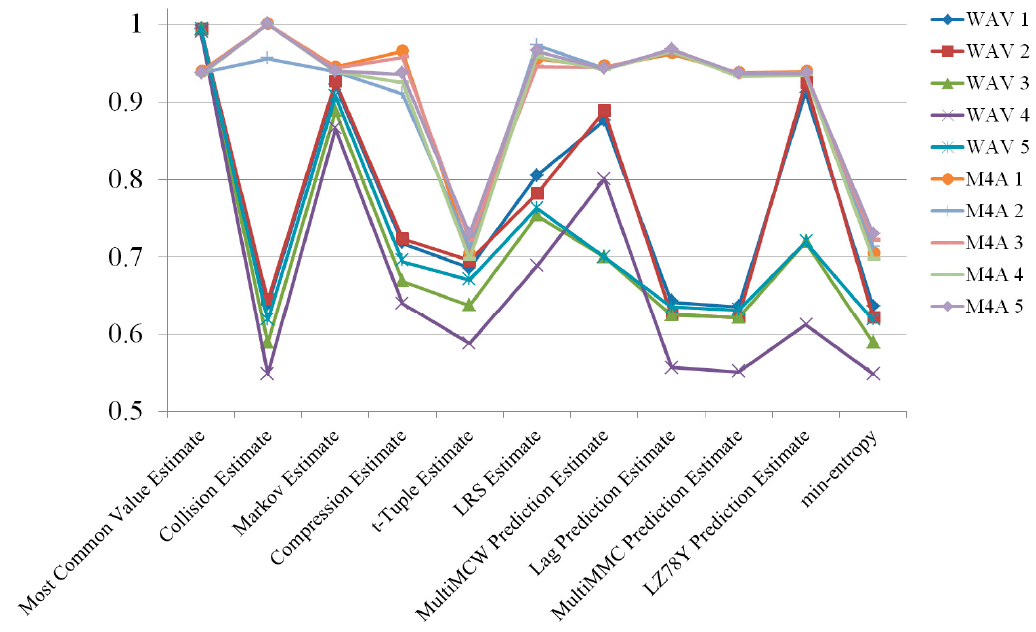
Figure 9. Randomness estimation results of the radio signals collected with 10 s delay.